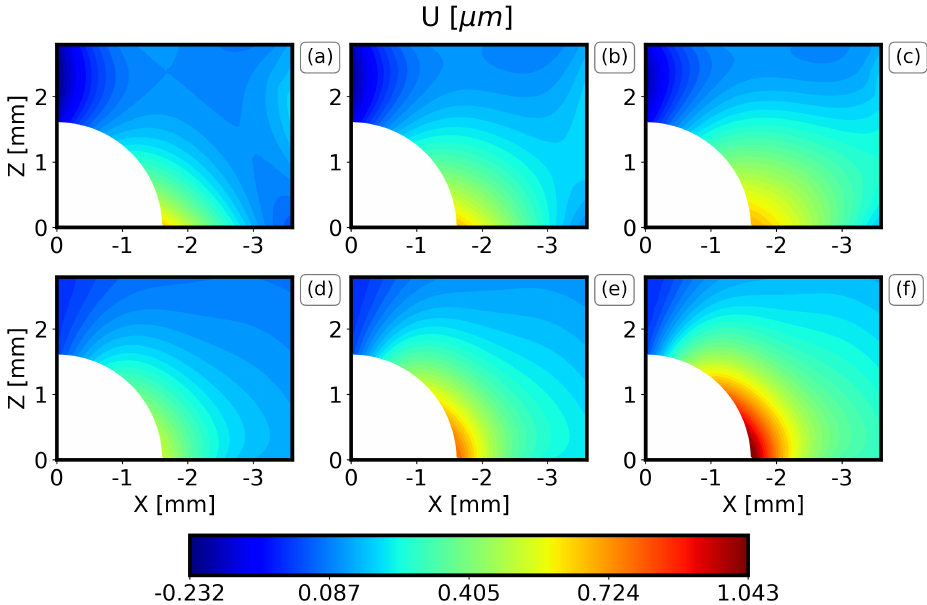
Figure 10. Comparison of DIC measurements and PC results for the U − displacement field and a drilling depth 2.0 mm. ( a ) Expected experimental value minus one standard deviation, ( b ) expected experimental value, ( c ) expected experimental value plus one standard deviation, ( d ) expected PC value minus one standard deviation, ( e ) expected PC value, ( f ) expected PC value plus one standard